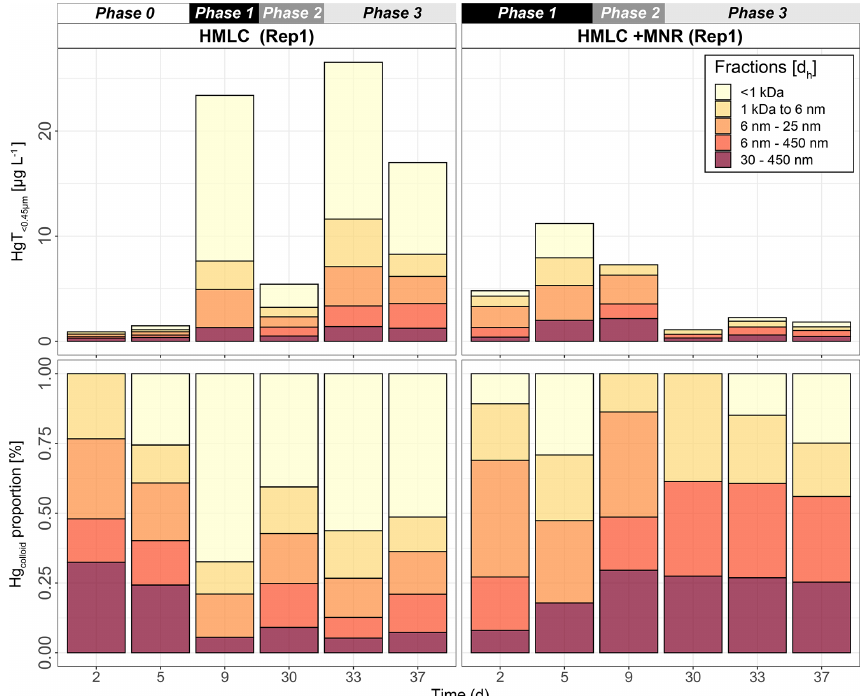
Figure 8. Size distribution of Hg estimated after AF4 fractogram deconvolution for Rep1 of cornfield soil incubation (HMLC and HMLC + MNR) subdivided into phases (0–3). The concentration of HgT in size fractions was calculated using an external calibration of the ICP–MS directly after the AF4 run. The concentration of HgT in “ < 1kDa” was calculated by subtracting the sum of the fractions from the HgT concentration in the same sample measured separately by ICP–MS. The fractograms of all analyzed time points are shown in the Supplement (Figs.